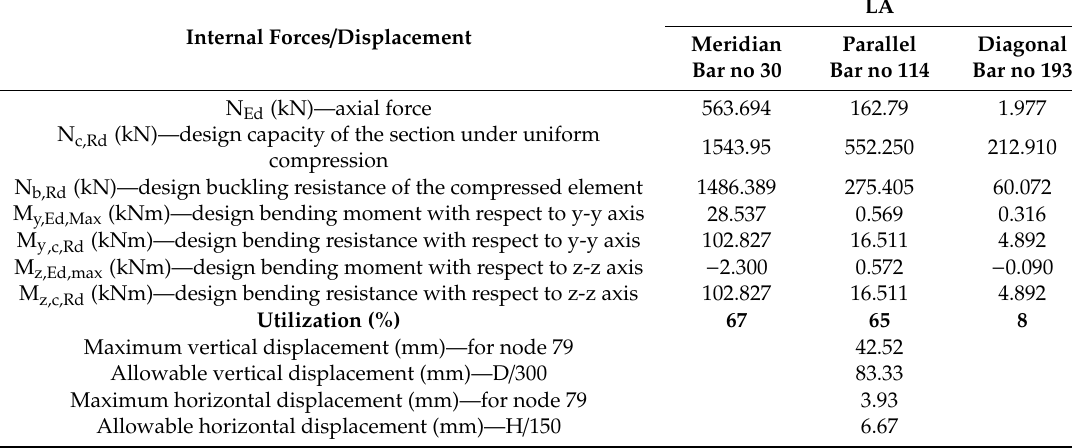
Table 8. Values of the internal forces and the maximum horizontal and vertical displacement of node 79 for LA.